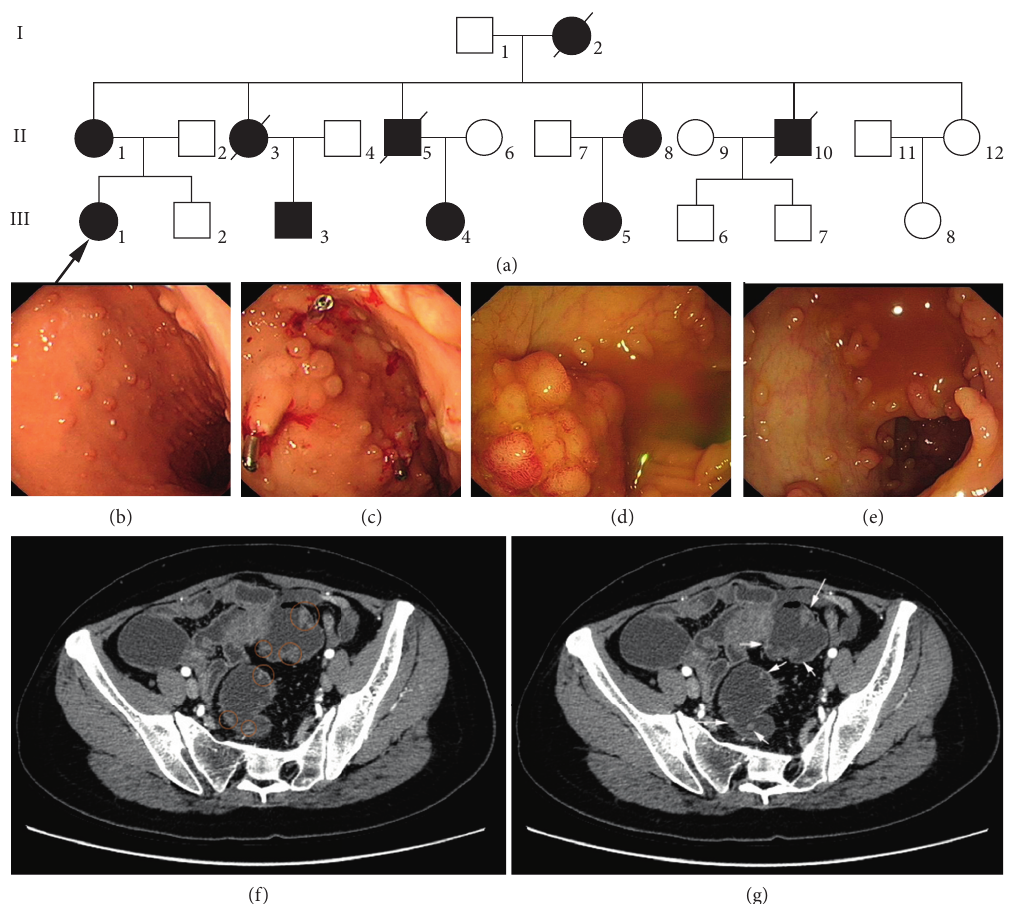
Figure 1: (a) Familial adenomatous polyposis (FAP) family pedigree. Proband (III1) had multiple sites of adenomatous polyposis of the colon and rectum at 28 years of age, (b), (c) gastroscopy and (d), (e) colonoscopy, was diagnosed with “colon cancer” at age 31. Cohort members I2, II3, 5, and 10 all died of “colon cancer and adenomatous colonic polyposis.” Members II8, III4, 5, and 3 had adenomatous colonic polyposis. Members I2 and II8 also suffered from adenomas of the common bile duct. (f), (g) CTimages of II8 before total colorectal resection; the images show changes in the distal stomach, pancreas, and duodenum, polyps in the rectum and sigmoid colon wall, and the heterogeneous fatty